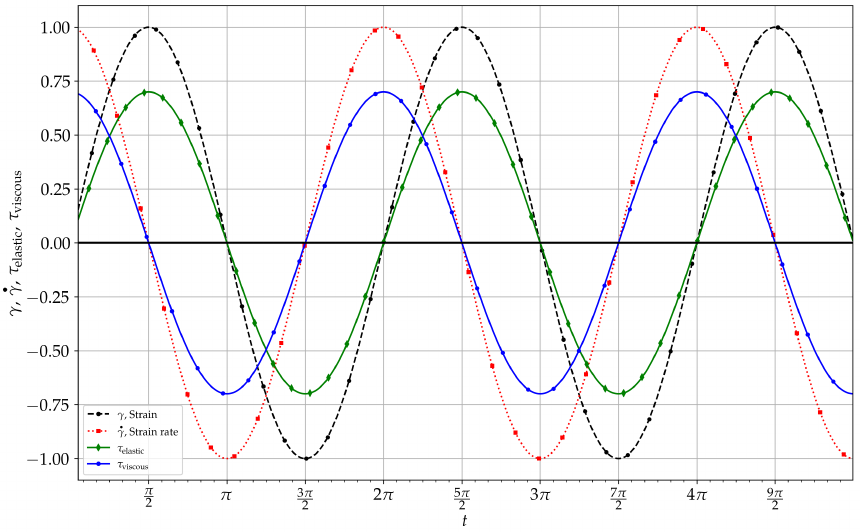
Figure 1. Strain rate and stress of ideal elastic and viscous substances under an oscillating strain γ = γ 0 sin ( ω t ) .